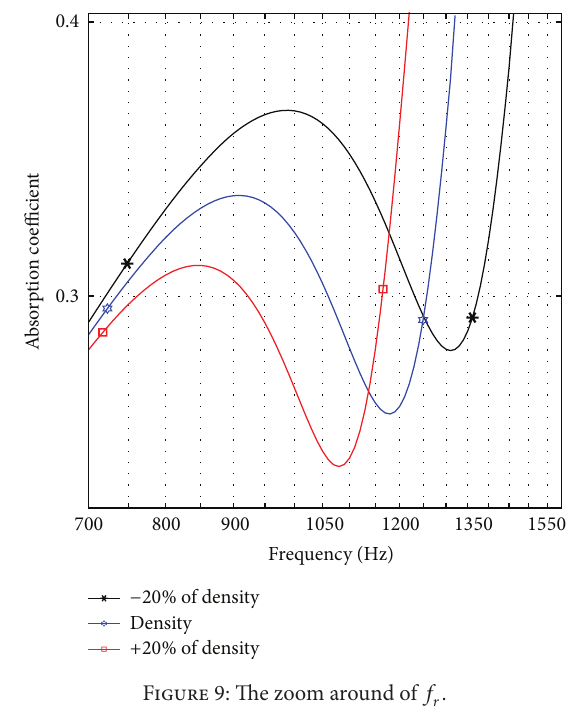
Figure 7: The zoom around of 𝑓 𝑟 .